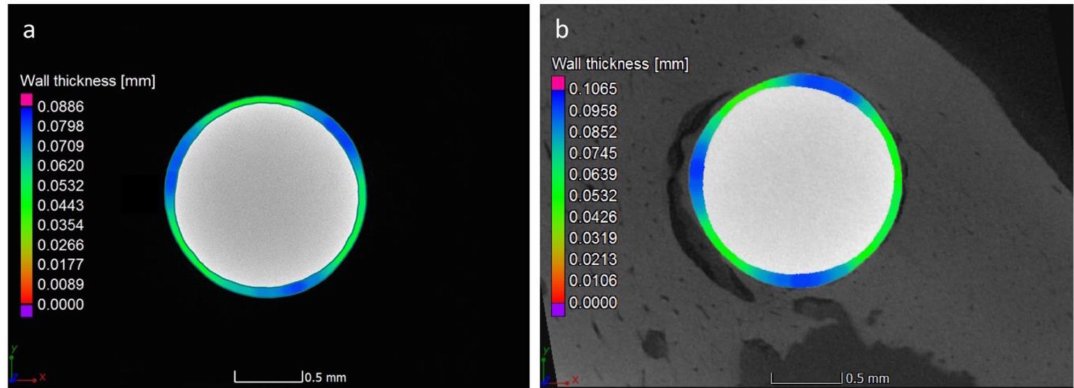
Figure 9. An example of the micro-CT transverse cross-sectional views of the sphene-coated implants with a coating thickness color map: ( a ) before the insertion; ( b ) positioned into the bone after 28 days of